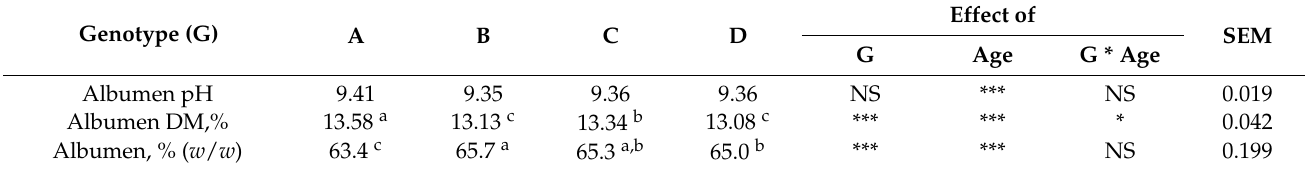
Table 4. Effect of hen genotype A, B, C, and D, age, and their interaction on LS-means of egg albumen parameters between the 21st and 54th week of age, n = 180 for genotype A and 270 for genotypes B, C and D. Genotype (G)